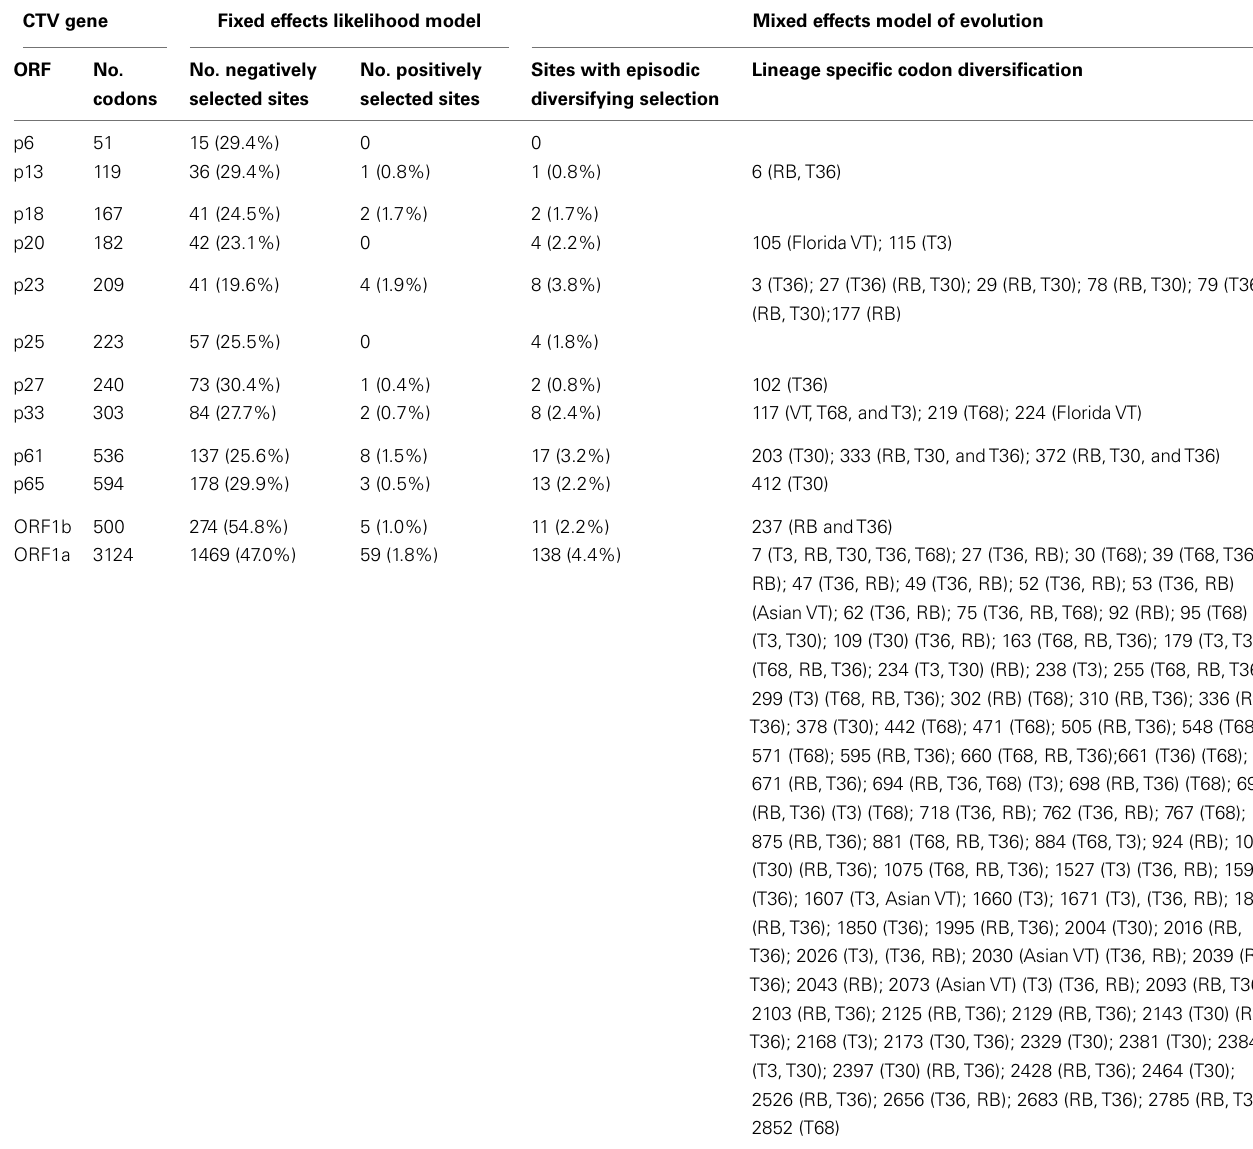
Table 4 | Positively and negatively selected codons present in CTV ORFs identified by FEL and MEME